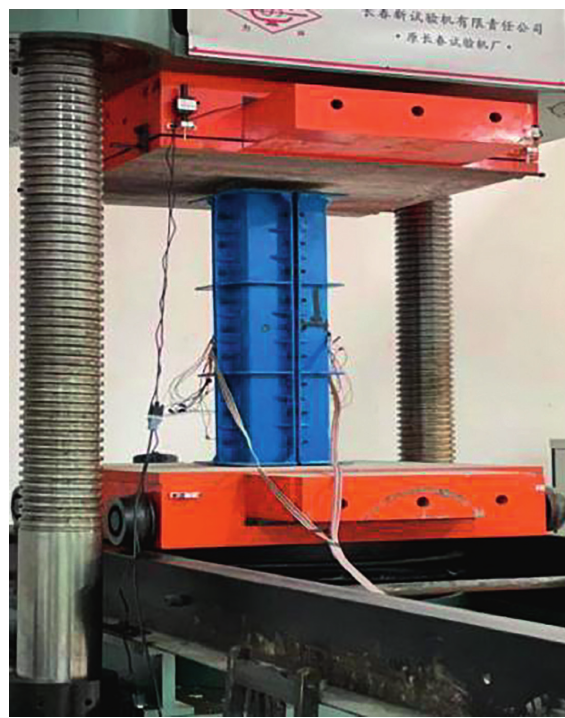
Figure 5: Testing machine. Table 2: Main results of the